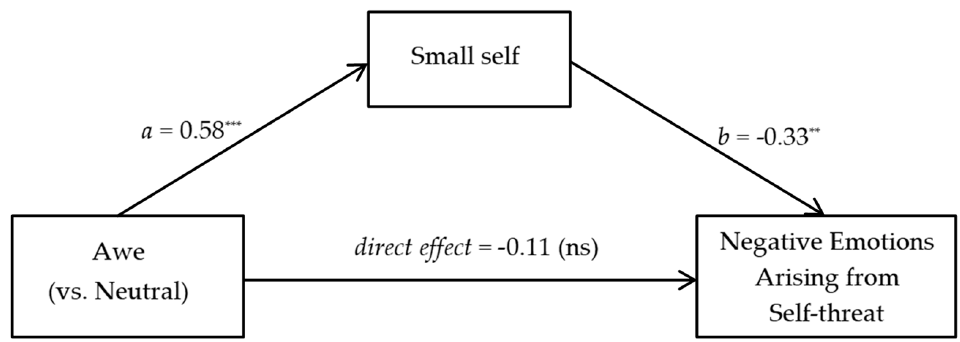
Figure 3. Results of mediation analysis. Notes: ** p < 0.01, *** p < 0.001, ns = not significant.